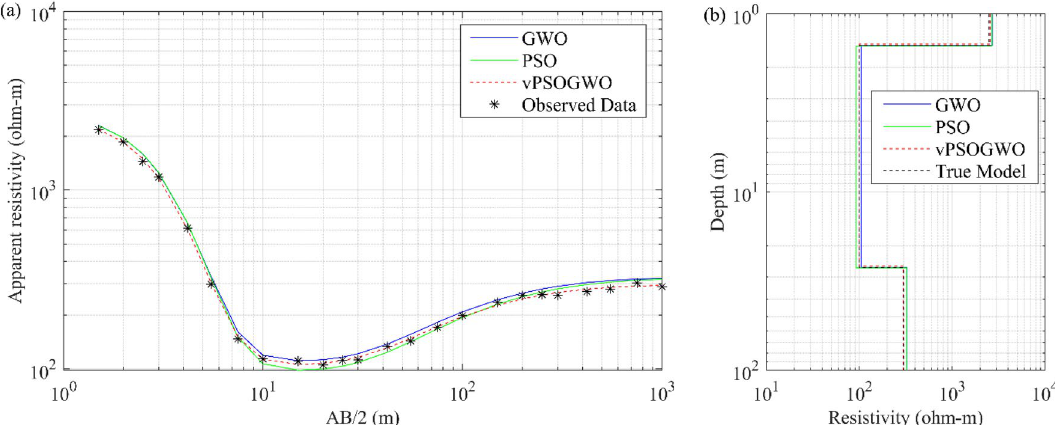
Figure 4. Three-layer noisy DC synthetic data: ( a ) observed apparent resistivity curve (*) and the best-fitted apparent resistivity curve using vPSOGWO, GWO, and PSO; ( b ) 1D mean model (bpdf > 68.27% CI) inverted by vPSOGWO (red), GWO (blue) and PSO (green) with a true model